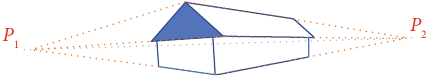
Figure 9: Two vanishing